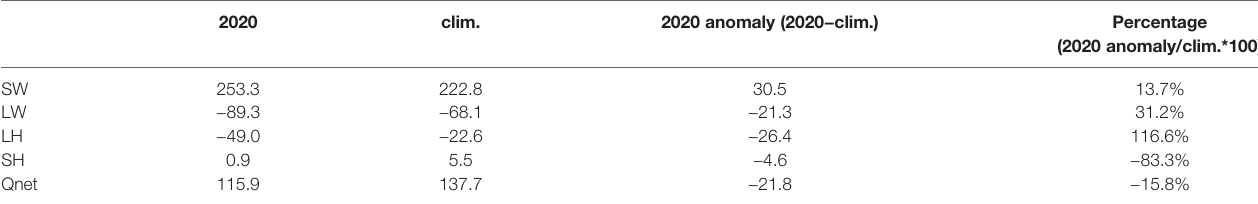
TABLE 2 | Magnitudes, anomalies, and percentages for heat fl ux components and their summation (i.e., Qnet=SW+LW+LH+SH) during April over the northeastern basin of the Yellow Sea.